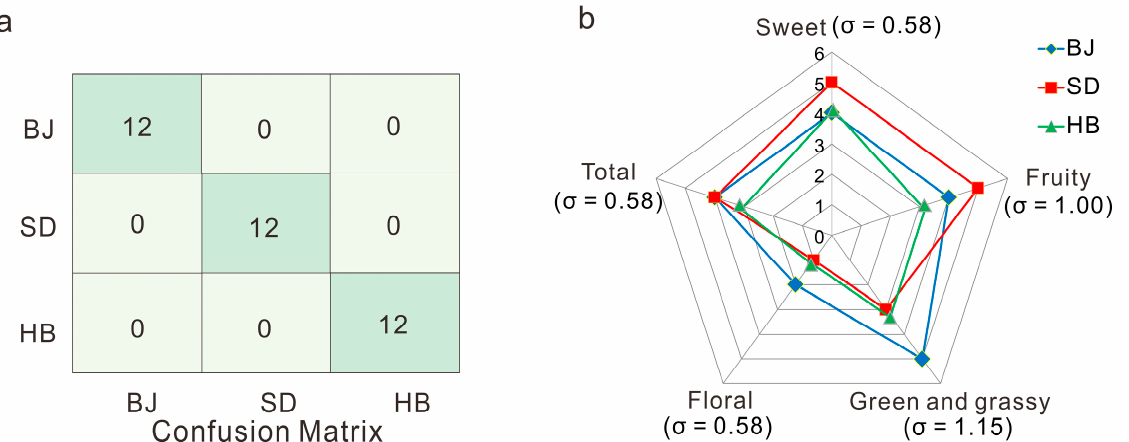
Figure 4. ( a ) The confusion matrix of PLS-DA model; ( b ) the sensory evaluation of the aroma pro- files of peach from three cultivation regions of BJ, SD, and